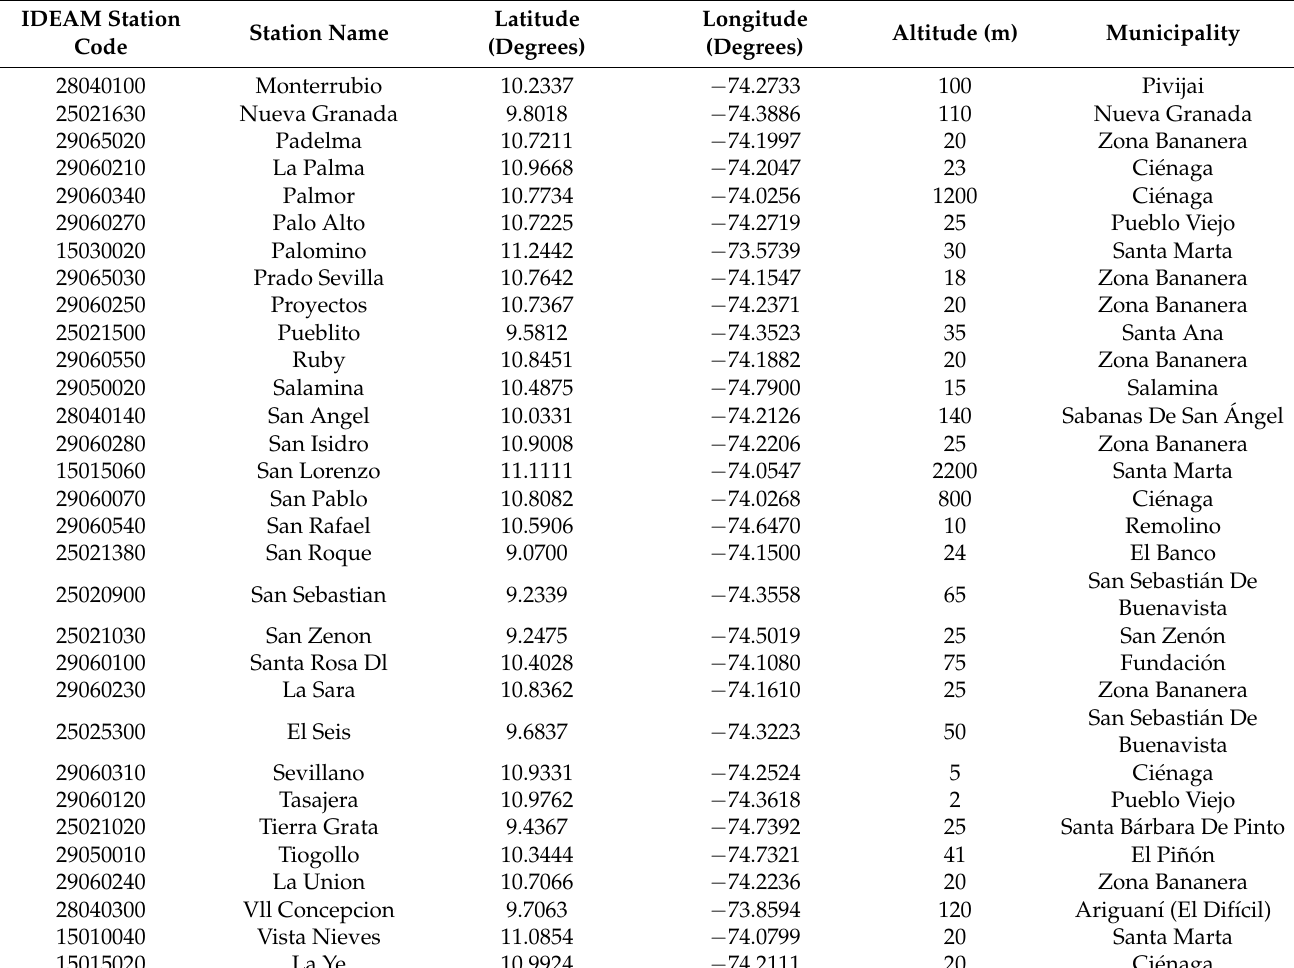
Figure A1: wavelets (Morlet) analysis central-west, Figure A2: wavelets (Morlet) analysis south, and Figure A3: wavelets (Morlet) analysis SNSM.